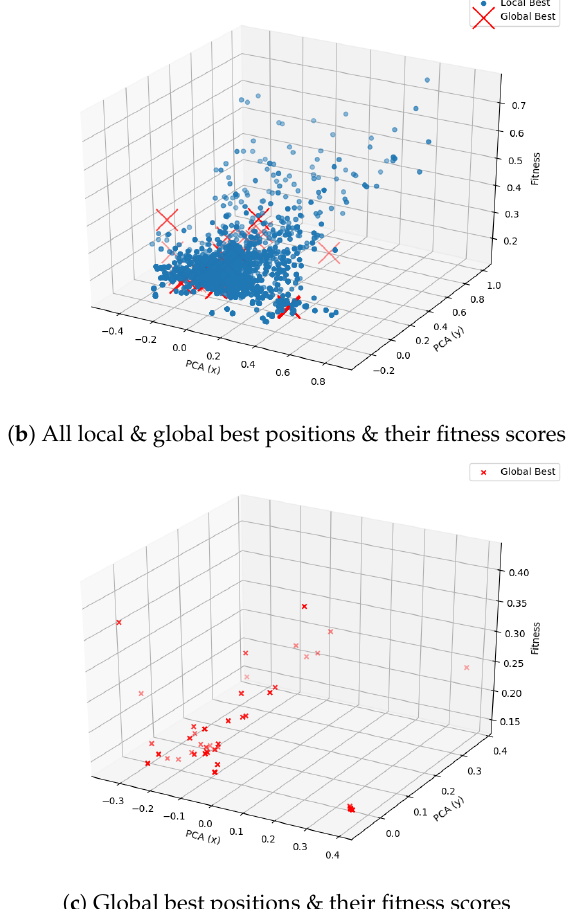
Figure 14. Example local and global best positions over time for the BLSK-S weight inheritance method (PCA for dimensionality reduction to display particle positions on two axes with fitness on the